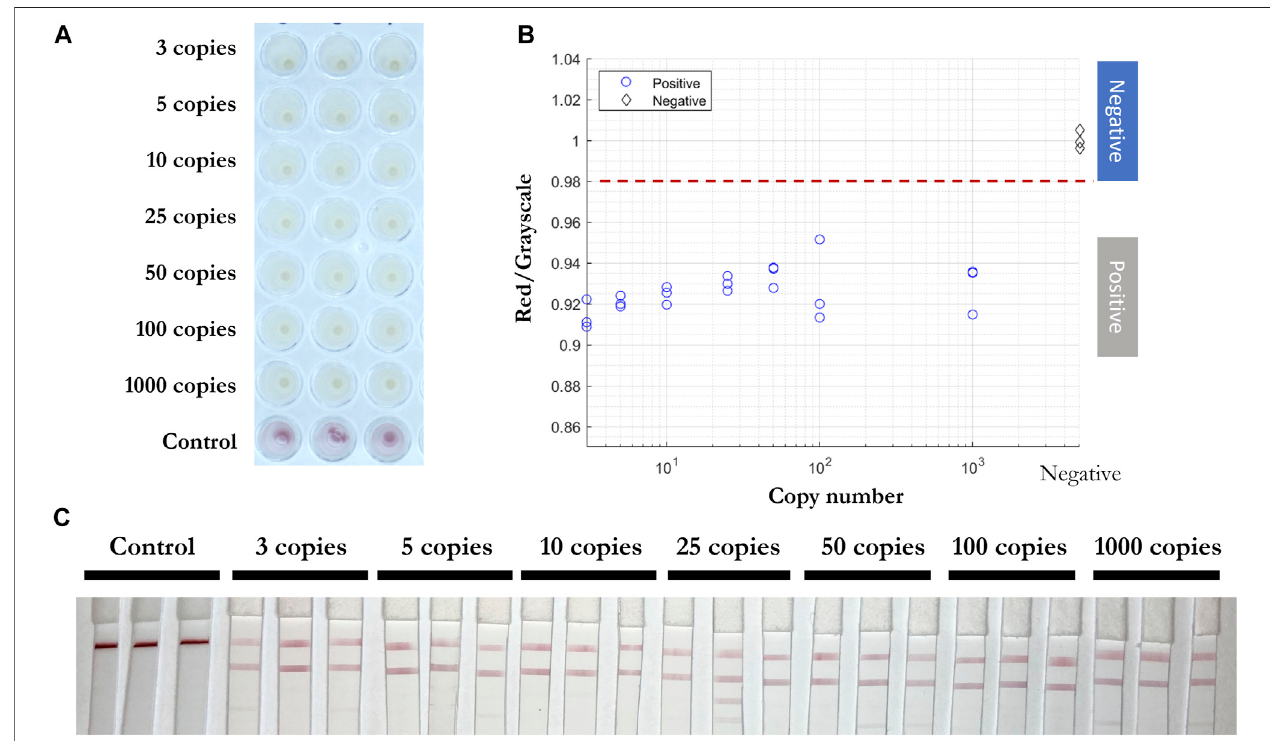
FIGURE8 | Direct RT-LAMP-LFIA testing ofspiked inactivated viralparticlesin nasopharyngeal swab specimens without aprior RNA puri fi cation or extraction. (A) RT-LAMP products for inactivated viral particles spiked in nasopharyngeal swab specimens (3, 5, 10, 25, 50, 100, and 1,000 copies) and negative control samples with three sets ofprimers, takenbyoverview camera. (B) Red/grayscale vs. copy numbers ofboth positive and negative samples. (C) LFIA read-outsforRT-LAMPproducts ampli fi ed for all three genes.